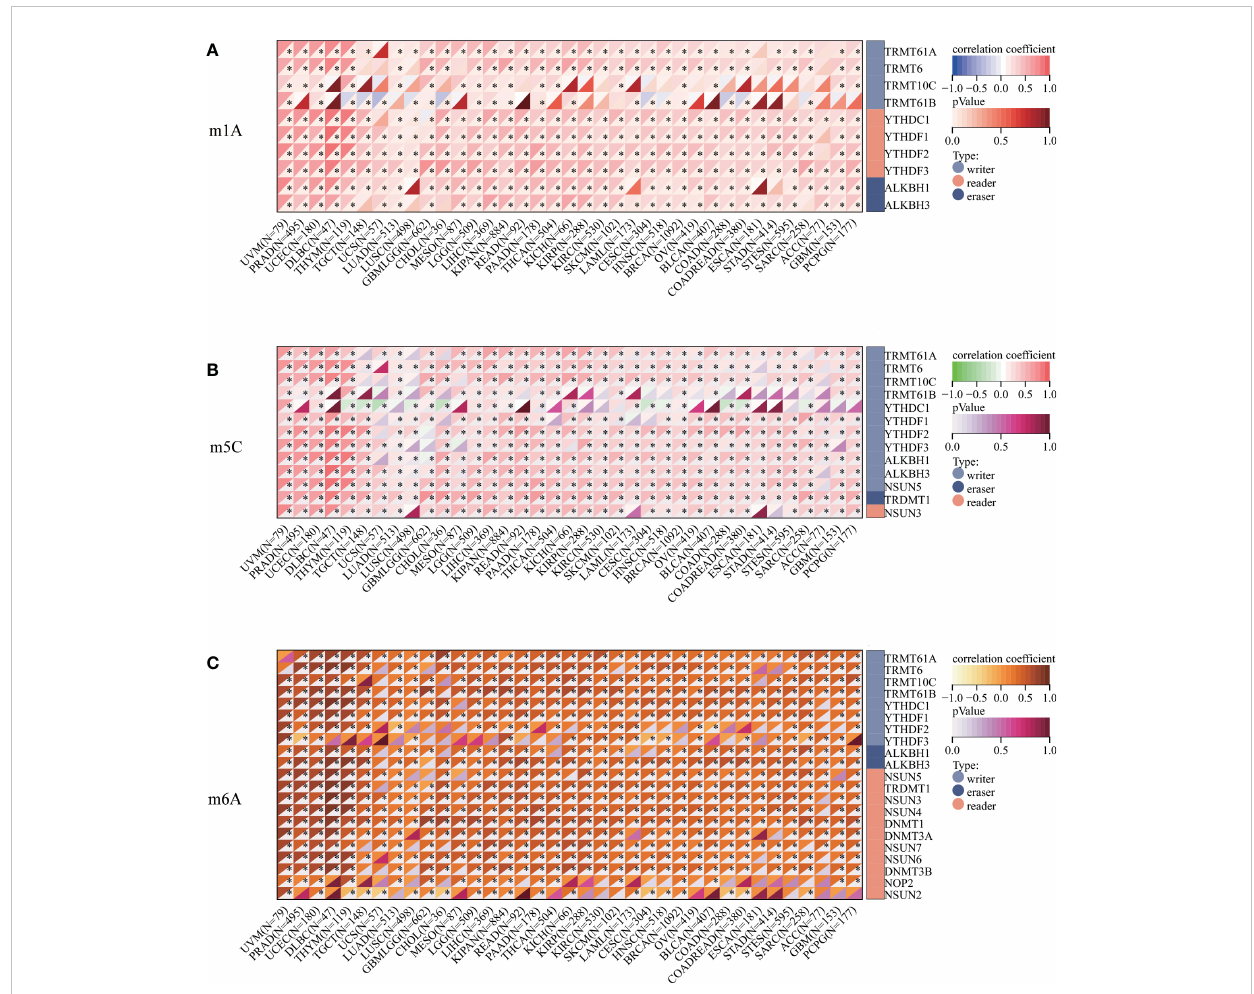
FIGURE 6 Correlation analysis between TPM4 expression and mRNA modi fi cation methylation regulatory factors. (A) m1A, (B) m5C, (C) m6A. Correlations depend on Pearson's rho values and statistical signi fi cance. (*p <